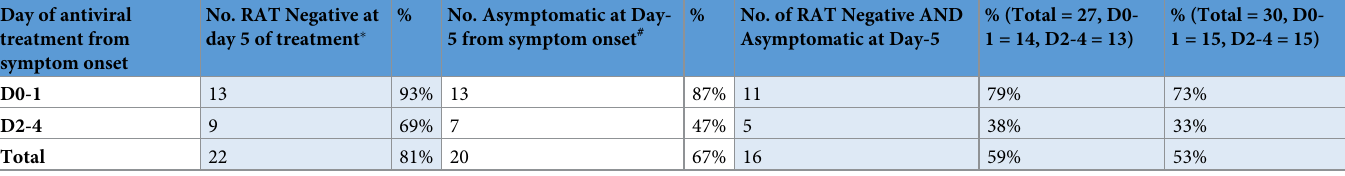
Table 3. Outcomes based on time to molnupiravir commencement from symptom onset. Day of antiviral treatment